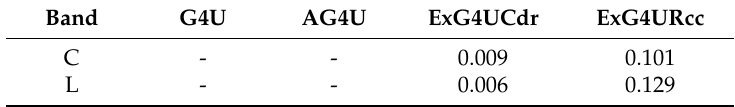
Table 4. Normalized oriented dihedral scattering power statistics for oriented urban areas.